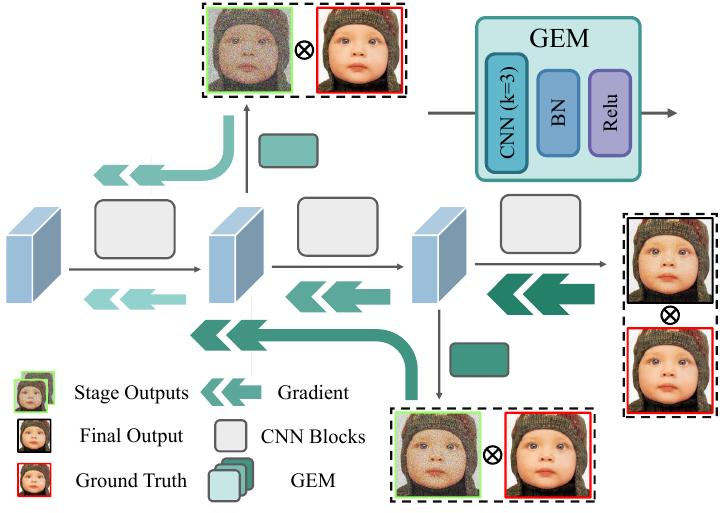
Figure 3. The flow chart of